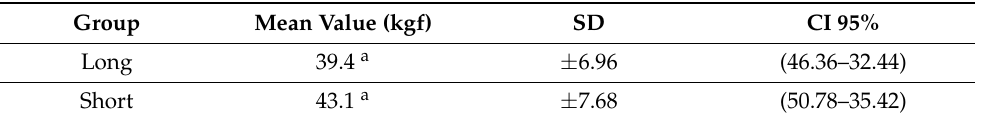
Legend: CI indicates confidence interval. Different letters indicate statistically significant differences between columns.